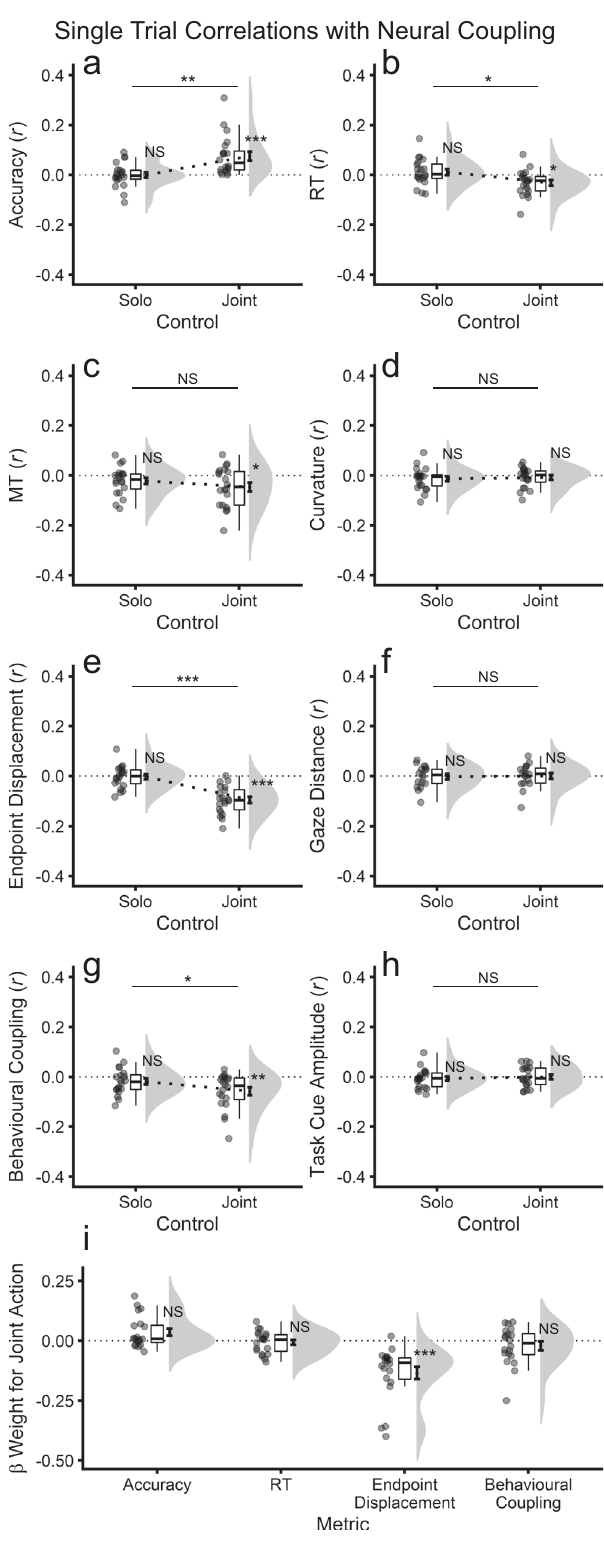
indicated that joint control interpersonal correlations were sig- ni fi cantly higher on correct ( M = = 0.09, SD = 0.07) compared with error trials ( M = 0.03, SD = 0.04; t 19 = − 4.15, p = 5.46e-04), but that solo interpersonal correlations did not differ signi fi cantly